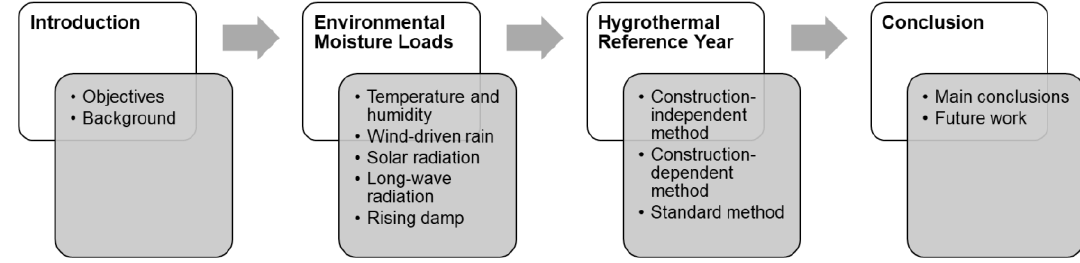
Figure 1. Structure of the literature review.